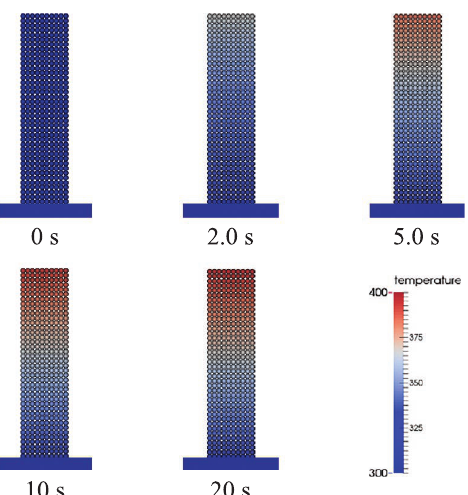
Fig. 9 Verification test system for the heat flux model in the MPS method (Takabatake et al., 2016) Copyright: (2016) Elsevier B.V.